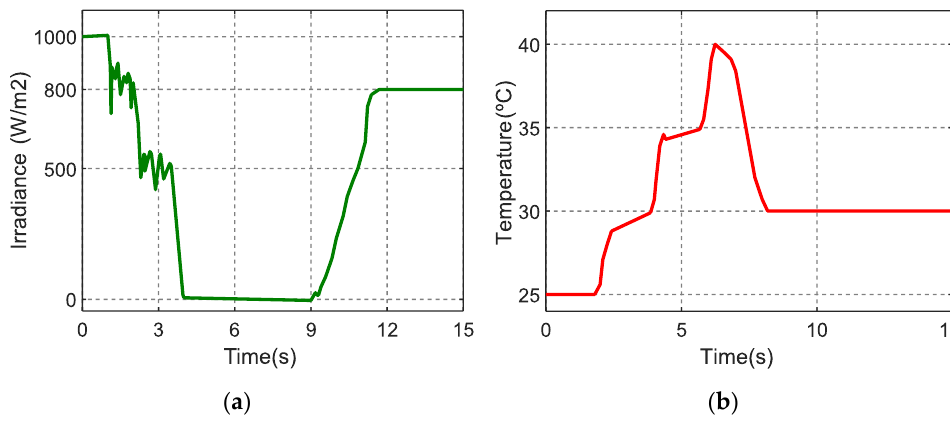
Figure 16. Solar plant curves: ( a ) irradiance; ( b ) temperature.